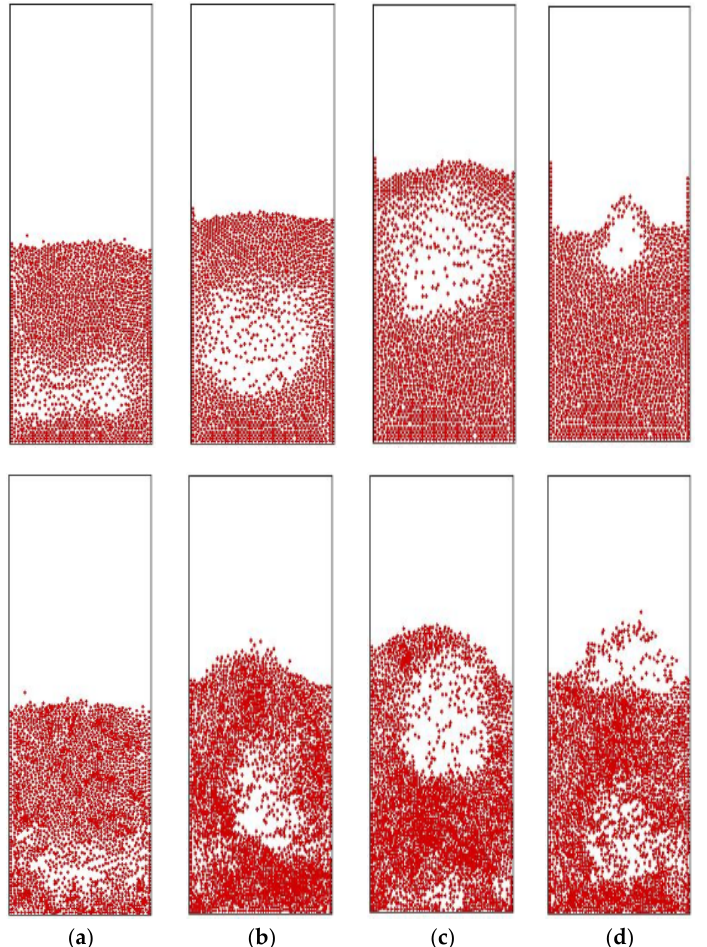
Figure 10. Simulated snapshots of particle distribution with a coarse grain ratio l = 2. Upper: simulation results obtained by the traditional coarse grain DEM-CFD method (TM). Bottom: simulation results obtained by the current dynamic coarse grain DEM-CFD method (PCPM). ( a ) 0.36 s. ( b ) 0.40 s. ( c ) 0.44 s. ( d ) 0.48 s.